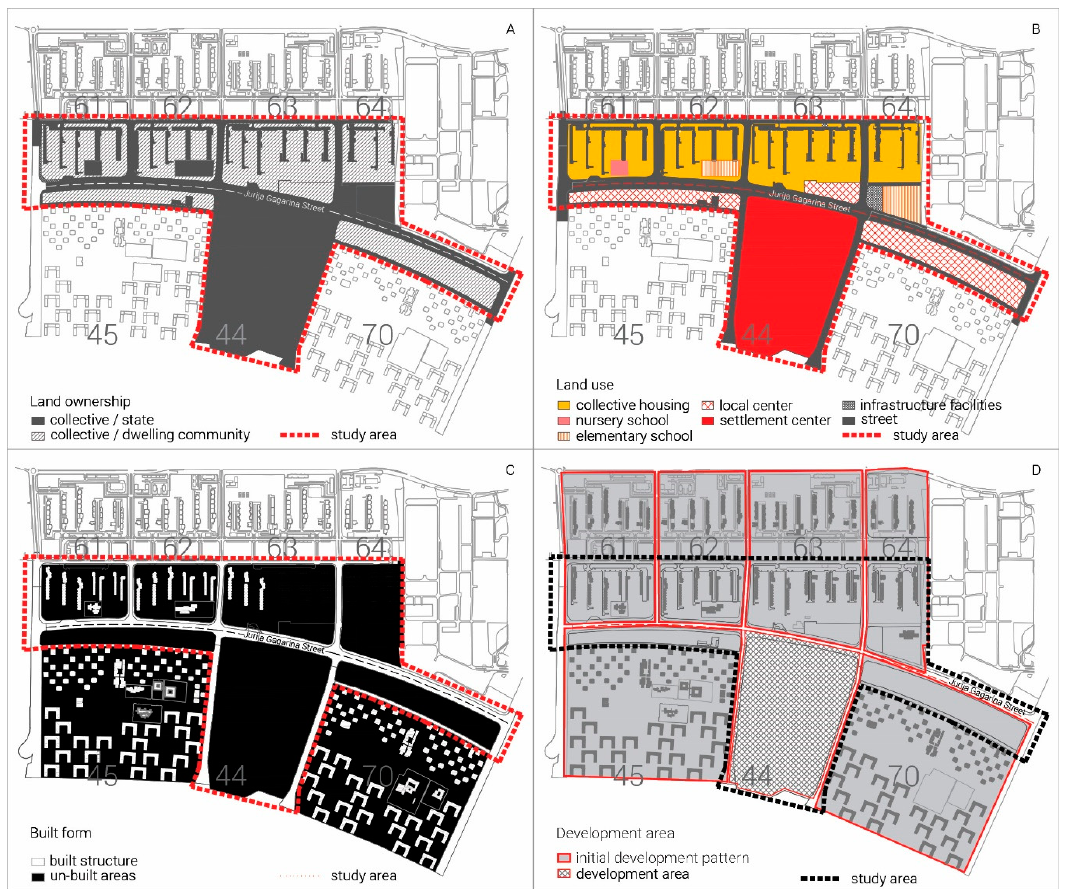
Figure 3. Morphogenesis of Jurija Gagarina Street, initial phase: ( A ) Land ownership, ( B ) land-use, ( C ) built form, and ( D ) pattern of growth (source: authors).